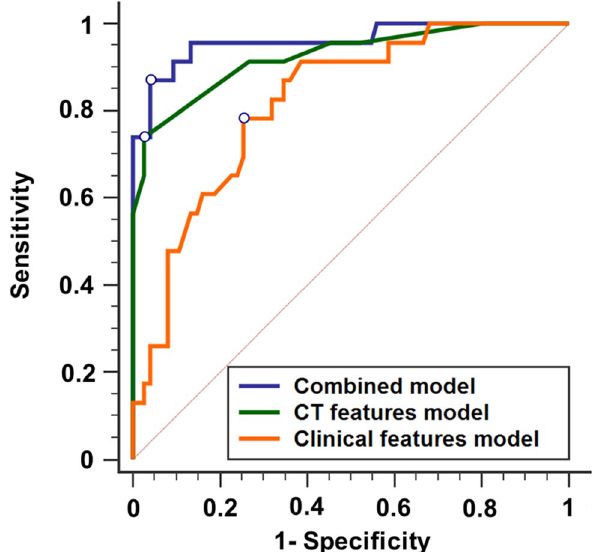
Figure 4. The performance characteristics of the logistic regression models for diagnosing patients with COVID-19 infection. Orange line, the model based on clinical variables; green line, the model based on CT features; purple line, the combined model with both clinical variables and CT